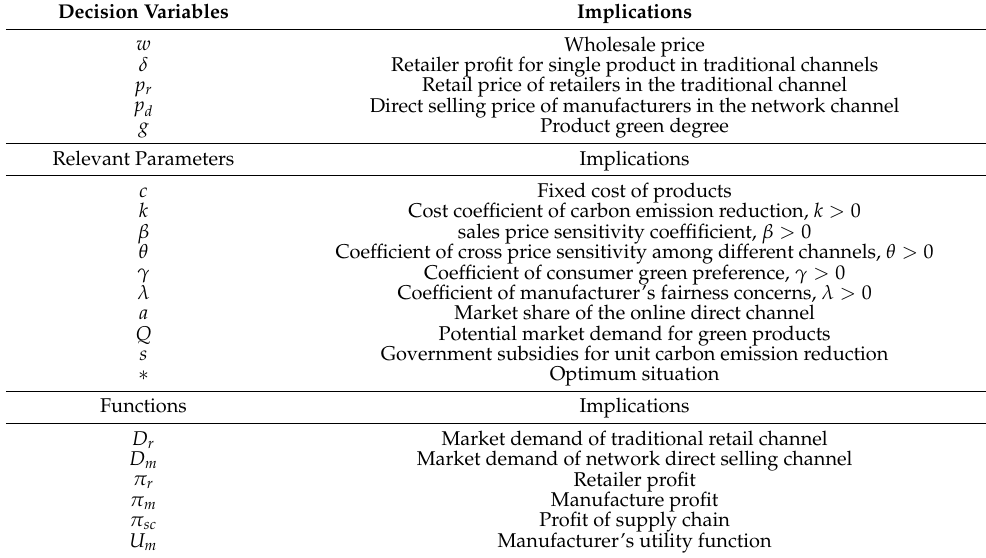
Table 1 defines the model parameters. Table 1. Model parameters and